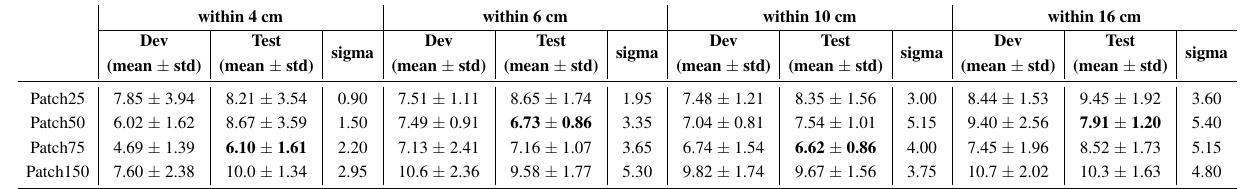
Table A9. HTERs (%) of GLOH features (no overlap, PCA 95%).